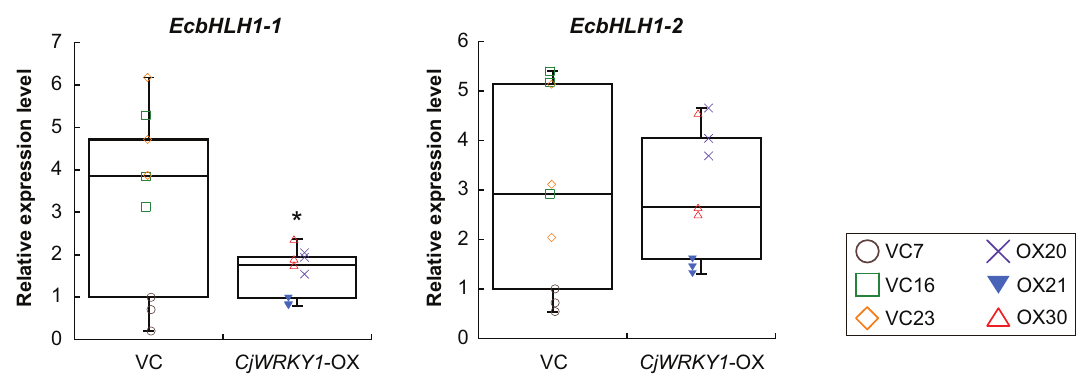
Fig 4. Effects of overexpression of the CjWRKY1 gene on bHLH transcription factor genes in transgenic California poppy cell lines. The expressionlevels of EcbHLH1-1 and EcbHLH1-2 were determined by quantitative RT-PCR. Nine biologicalreplicateswere used of each cell line. An asterisk indicatesa significantdifference comparedwith VC cell lines ( * P < 0.05; two-tailedpairedStudent’s t -test).